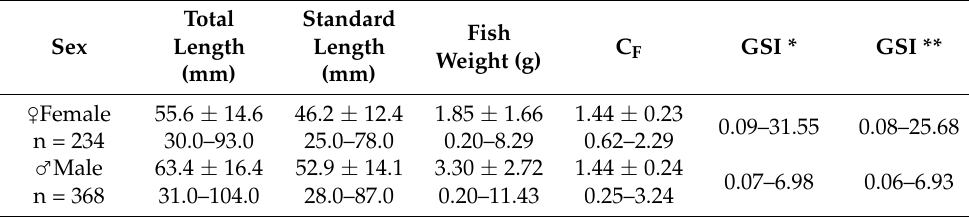
Table 2. Morphological and biological characteristics of stone moroko, Pseudorasbora parva inhabiting the Wardynka river, Poland. Data are presented as mean ± SD and range.